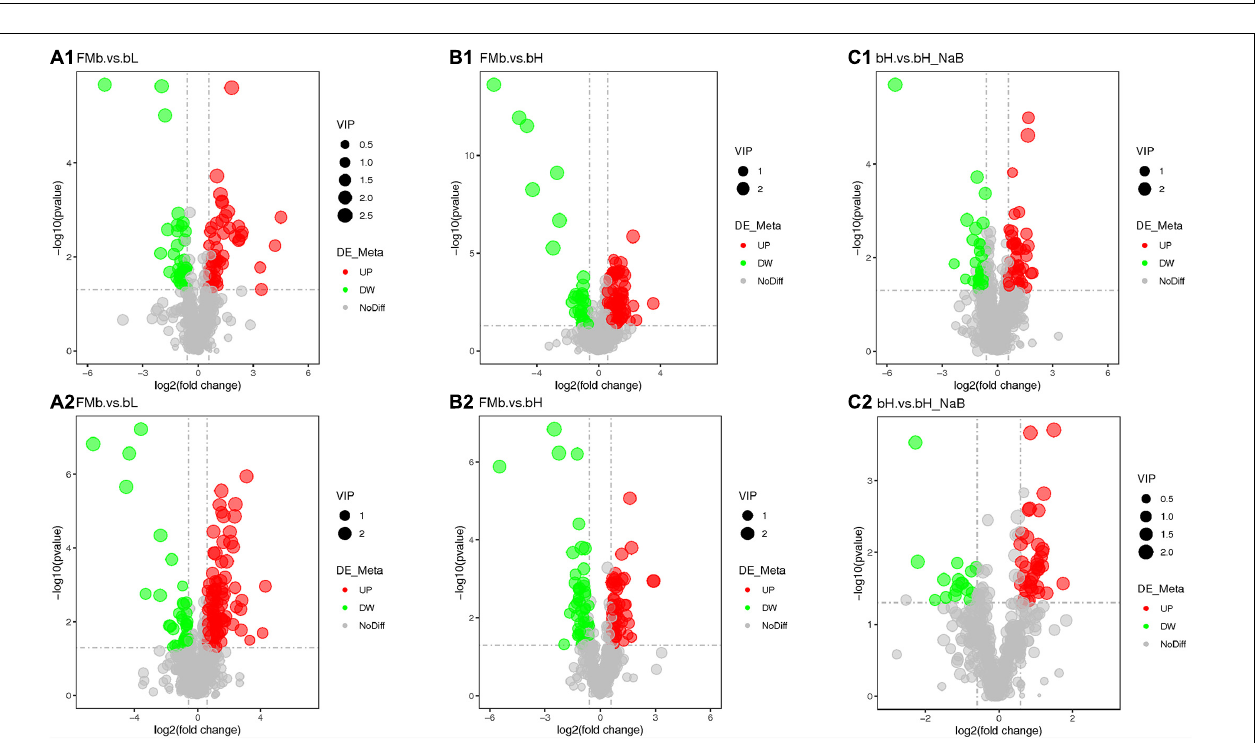
FIGURE 4 | KEGG pathway classification and enrichment analysis of the DEGs in the distal intestine of hybrid grouper. KEGG classification of all DEGs (A–C) . Top 30 enriched of KEGG pathways of FMb vs. bL (D) , FMb vs. bH (E) and bH vs. bHNaB (F) .